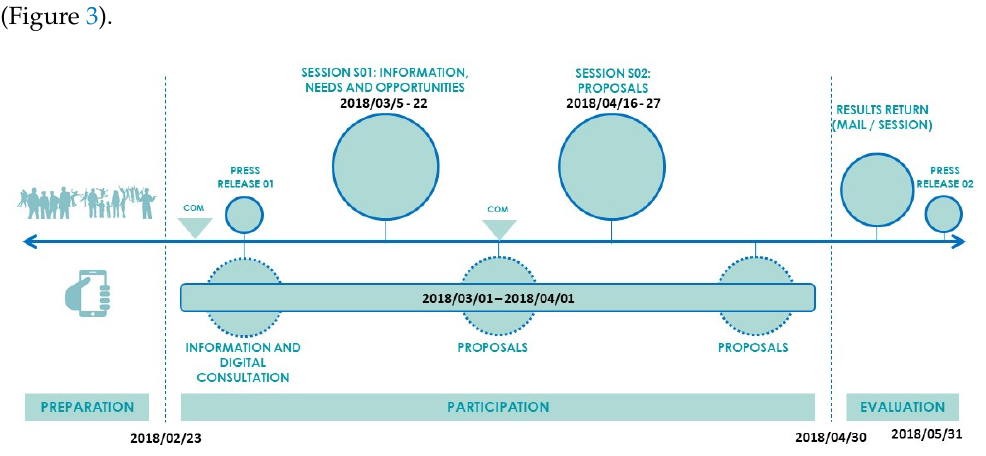
Figure 3. Engagement Framework diagram with the three phases: preparation, participation, and evaluation. Above the line, the main milestones for face ‐ to ‐ face participation Below the line, the main digital participation milestones (developed by the authors).